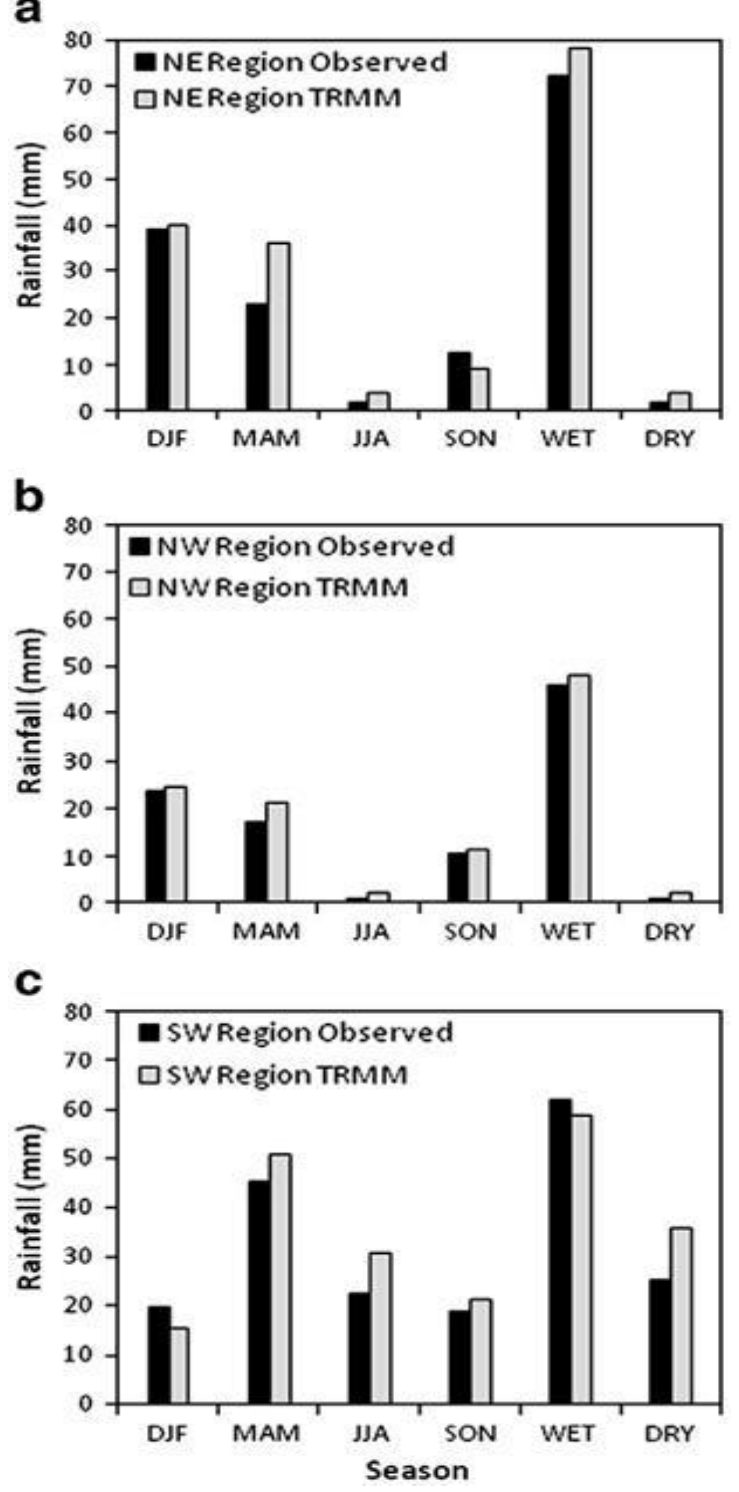
Figure 16. The comparison of the TRMM and the observed rainfall (mm) in the different seasons for ( a ) NE region, ( b ) NW region, and ( c ) SW region